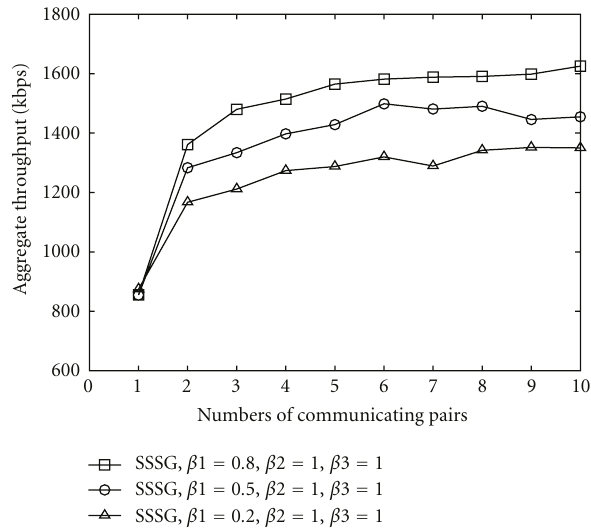
Figure 13: Aggregate throughput of SSSG with 1 channel having PU’s